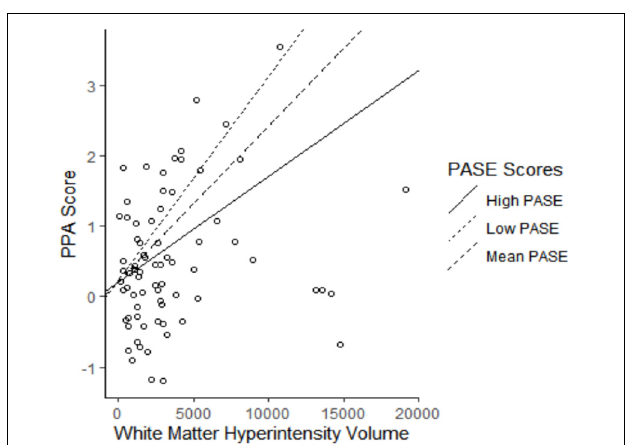
FIGURE 3 | The association of white matter hyperintensity (WMH) volume with foam sway moderated by physical activity level. Higher Physical Activity Score for the Elderly (PASE) attenuated the association between WMH volume and Foam Sway (Adjusted R 2 = 17.4%). High PASE = 1 SD above mean; Low PASE = 1 SD below